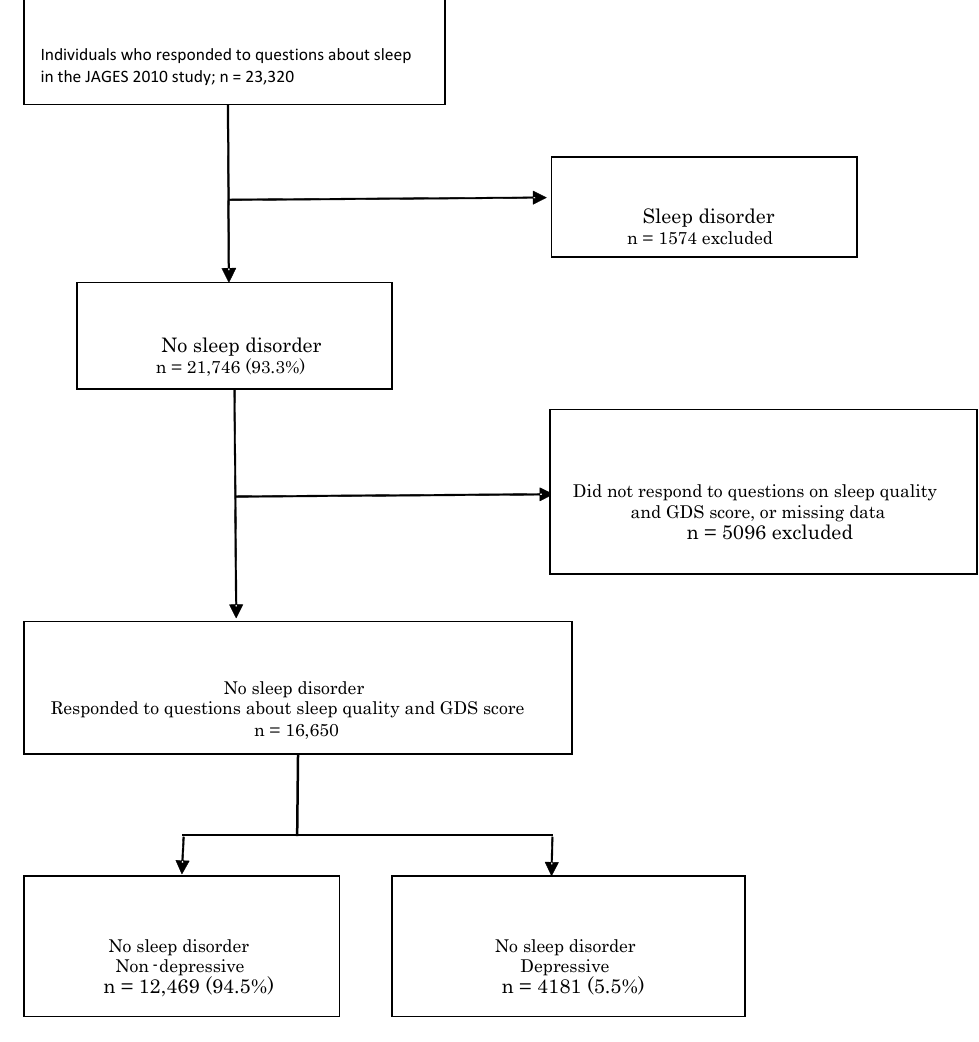
Figure 1. Flow chart of the enrollment process of the study participants. People with sleep disorders (n = 1574) and those who did not respond to the sleep quality module (n = 5096) were excluded. Finally, the data of 16,650 people (12,469 without depressive status, 4181 with depressive status) were analyzed. The average age of all respondents was 73.9 ± 6.2 years (range 65–101 years). The baseline characteristics of the respondents are provided in Table 1. Among the 12,469 non-depressive respondents (GDS score of < 5), 2286 (18.3%) had poor sleep. Of the 4181 depressive respondents (GDS score of ≥ 5), 1785 (43.3%) had poor sleep. The rates of poor sleep significantly di ff ered between non-depressive and depressive respondents ( p < 0.001; Figure